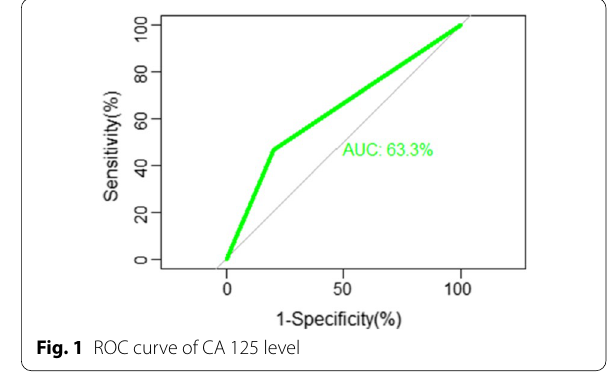
Fig. 1 ROC curve of CA 125 level